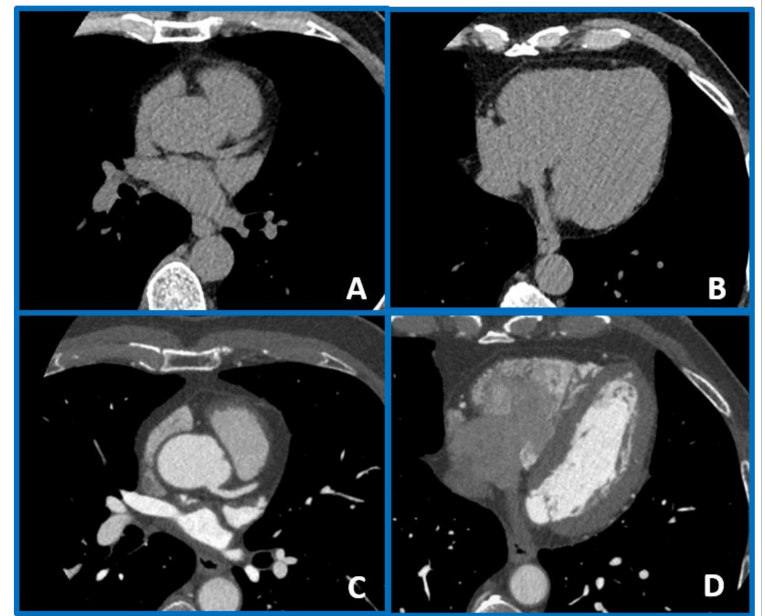
Figure 1. A case example of a 50-year-old man with arterial hypertension and noncardiac chest pain in which a coronary artery calcium score (CACS) value of 0 (panels ( A , B )) was associated with no coronary plaque at coronary computed tomography angiography (CCTA) (panels ( C , D )). In this case, CCTA evaluation did not add any information on top of